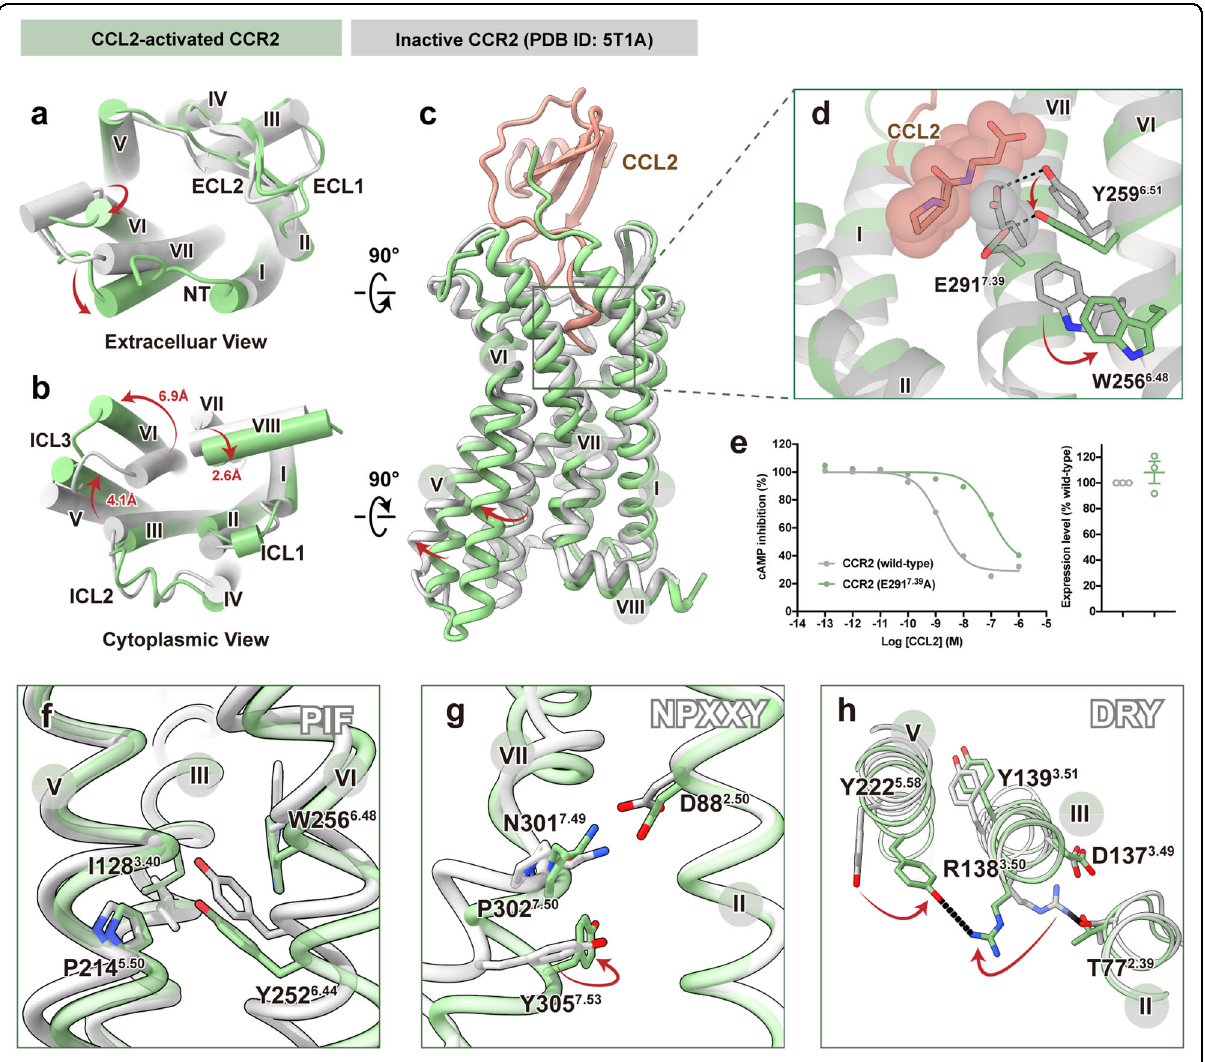
Fig. 3 Molecular basis for activation and G-protein coupling of CCR2 induced by CCL2. a – c Extracellular ( a ), cytoplasmic ( b ), and side view ( c ) of CCL2-bound CCR2 (green, active state) superimposed on the inactive CCR2 (gray, PDB: 5T1A). d Close-up view of the orthosteric binding pocket in CCR2. The N-terminal residues of CCL2 (brown) and E291 7.39 (gray) of inactive CCR2 are shown as spheres. e Dose-response curves for CCL2-induced G i signaling on CCR2 (wild-type) and CCR2 (E291 7.39 A) measured by Glosensor assay. Data are shown as means ± SEM; n = 3 independent experiments, performed with single replicates. f – h Close-up views of the conserved PIF ( f ), NPxxY ( g ), and DRY ( h ) motifs showing conformational changes along the pathway of receptor activation. Hydrogen bonds are depicted as black dashed